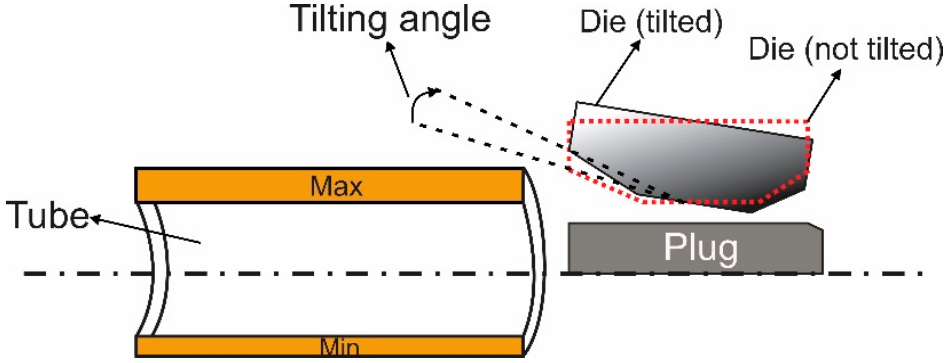
Figure 2. Tilting of the die for a positive (+) setup. Reprinted from ref. [21]. The as-received Cu tube (named ST0) was drawn to the final dimension in two steps (ST1 and ST2). The drawing process was performed by tilting the die ± 5 ◦ as shown in Figure 2. The tube drawn with +5 ◦ was named “4ST” and the one with − 5 ◦ was named “5ST”. The numbers “0”, “1” and “2” indicate “as-received”, “1st pass” and “2nd pass”, respectively. The plug diameter and diameters and the wall thickness of the tubes before and after drawing are shown in Table 2. Two sets were chosen: In the positive case (+),